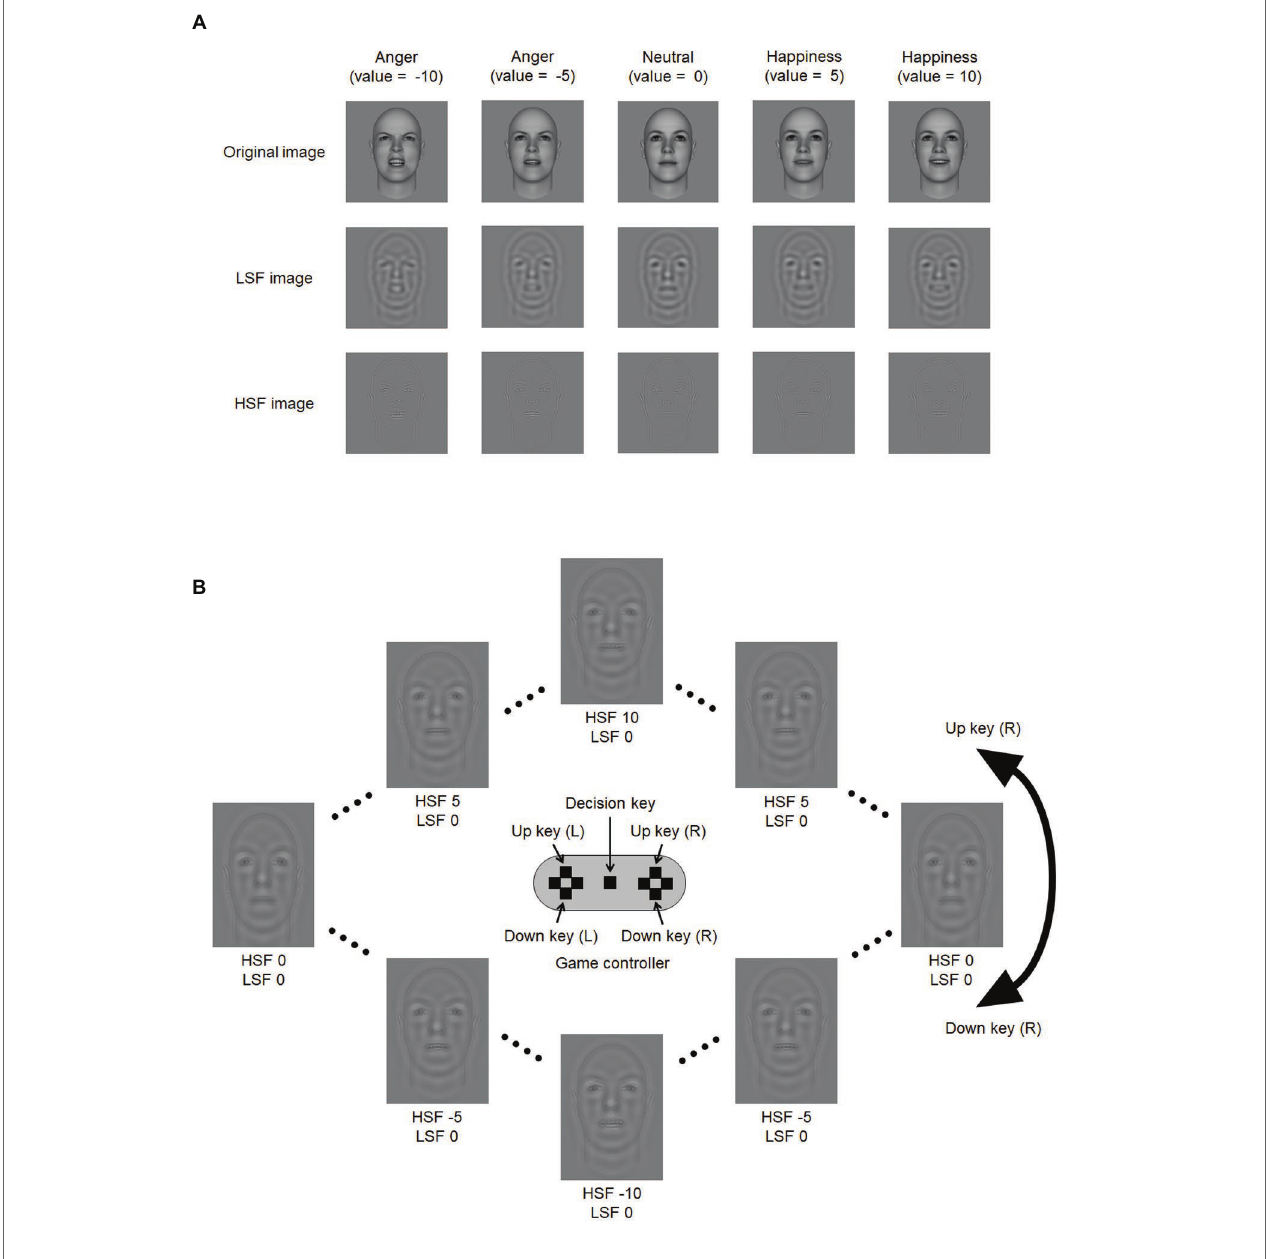
FIGURE 1 | Example of a randomly generated face image by FaceGen Modeller 3.5 software and schematic illustrations of the procedure. (A) Example images in the two frequency conditions and the original image. In the experiment, 21 variations in expression from the angriest (expression value of −10) to the most happiness (expression value of 10) were used. LSF images were filtered with low band-pass frequencies (4–8 c/f). HSF images were filtered with a high band-pass filter (16–32 c/f). (B) Schematic illustration of the game controller and the relationship between the up and down keys used to change the expression value of the image. In this schematic, the up key on the right side of the controller changes the HSF component of the image, ranging between −10 and 10 (in single steps) in a counterclockwise direction. The down key changes the HSF component of the image in the opposite direction. The up and down keys on the left side of the controller change the LSF component of the